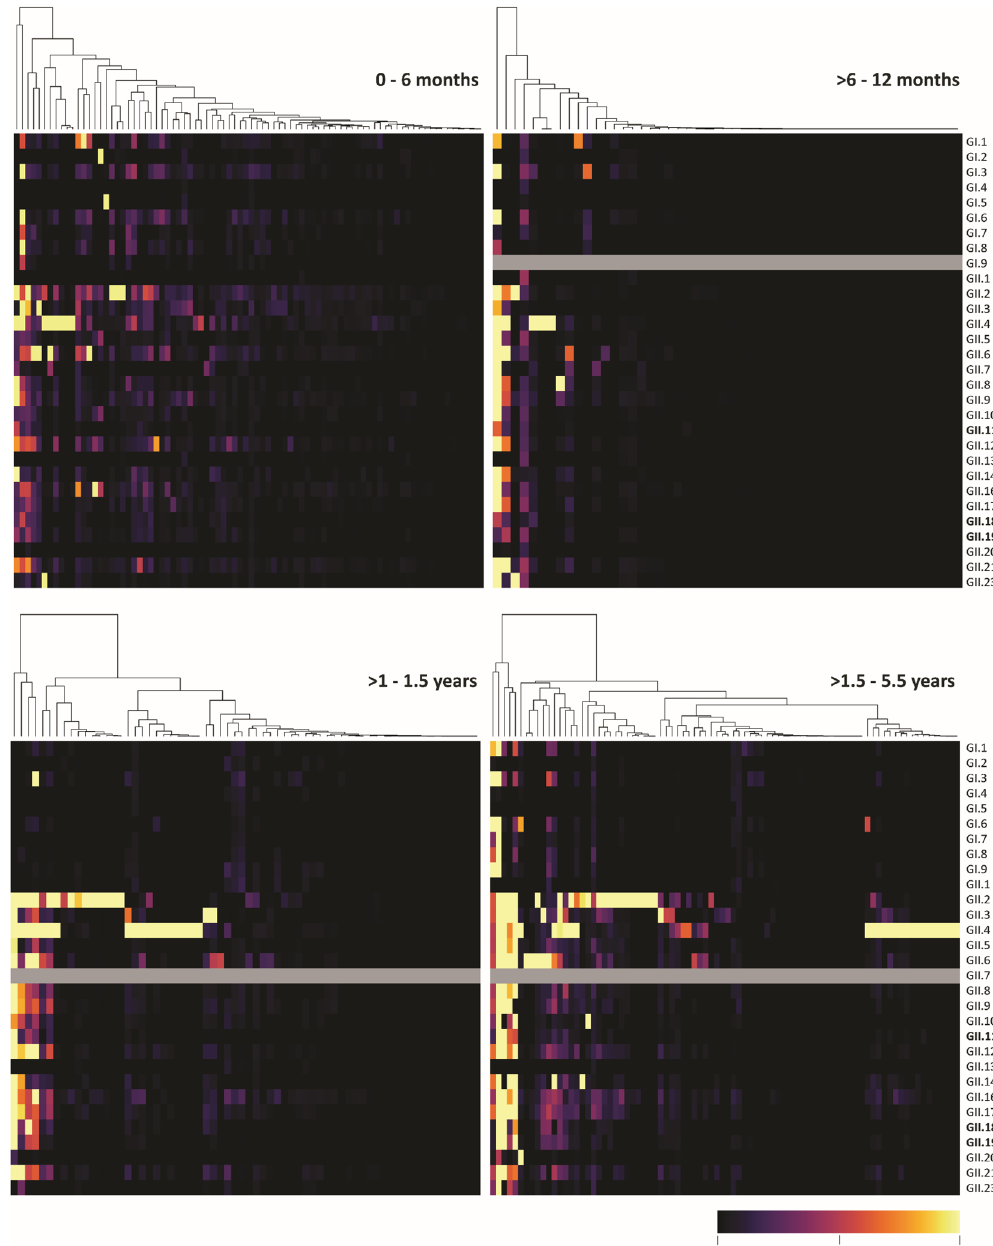
Figure 2. IgG responses against norovirus. Heat map of sera titers against P particles in the four age groups. Each column represents the antibody titers of one serum. Yellow depicts titers > 2560 and black titers < 40. Responses were clustered by antibody response. Grey marks antigens that were not spotted. In bold are the porcine